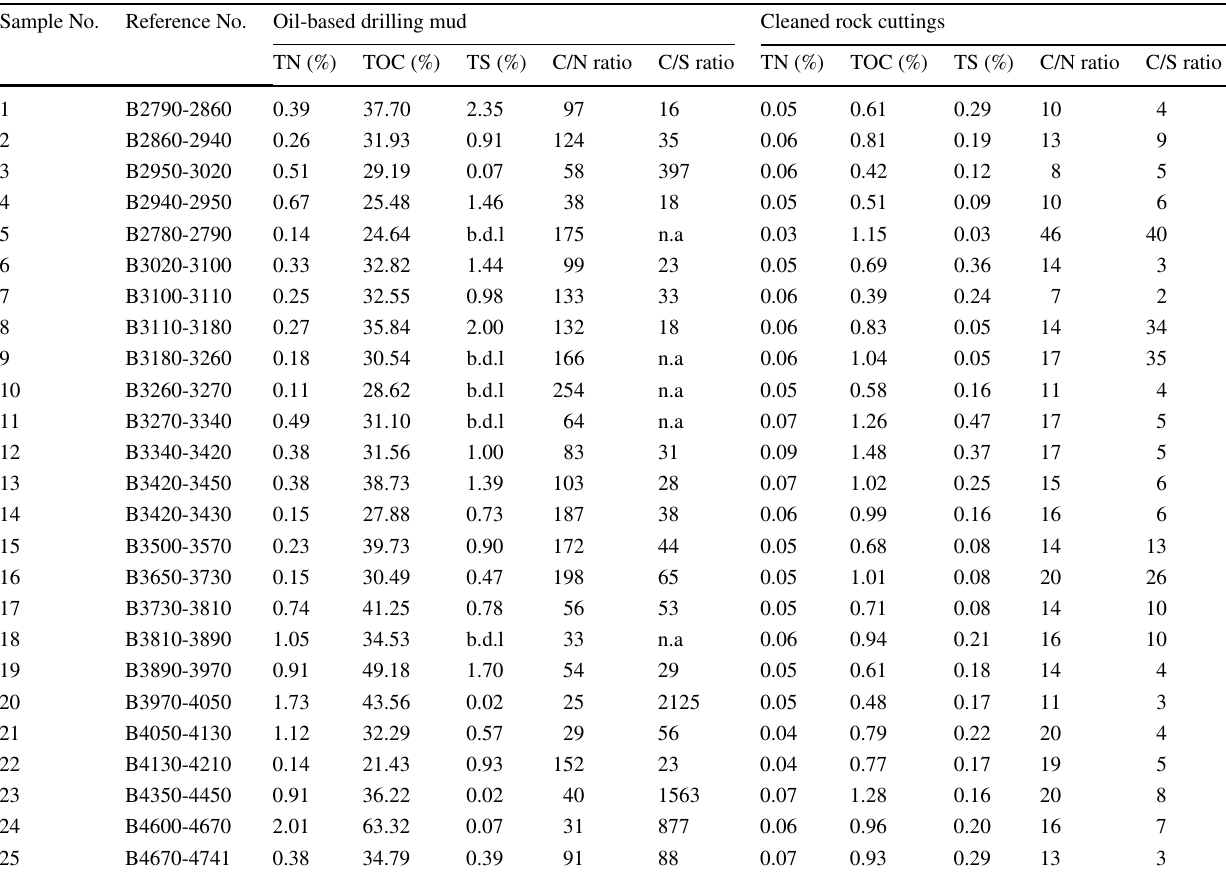
Table 1 Variations of bulk elemental geochemical data in oil-based drilling mud mixtures and cleaned rock cuttings in the Barracuda explora- tion well (TN: total nitrogen, TOC: total organic carbon, TS: total sulfur, b.d.l: below the detection limit, n.a: not applicable) Sample